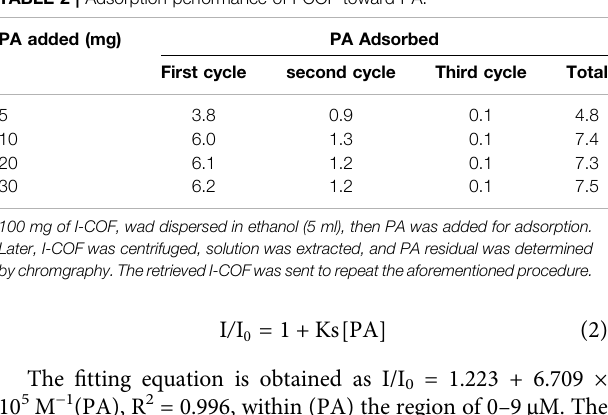
TABLE 2 | Adsorption performance of I-COF toward